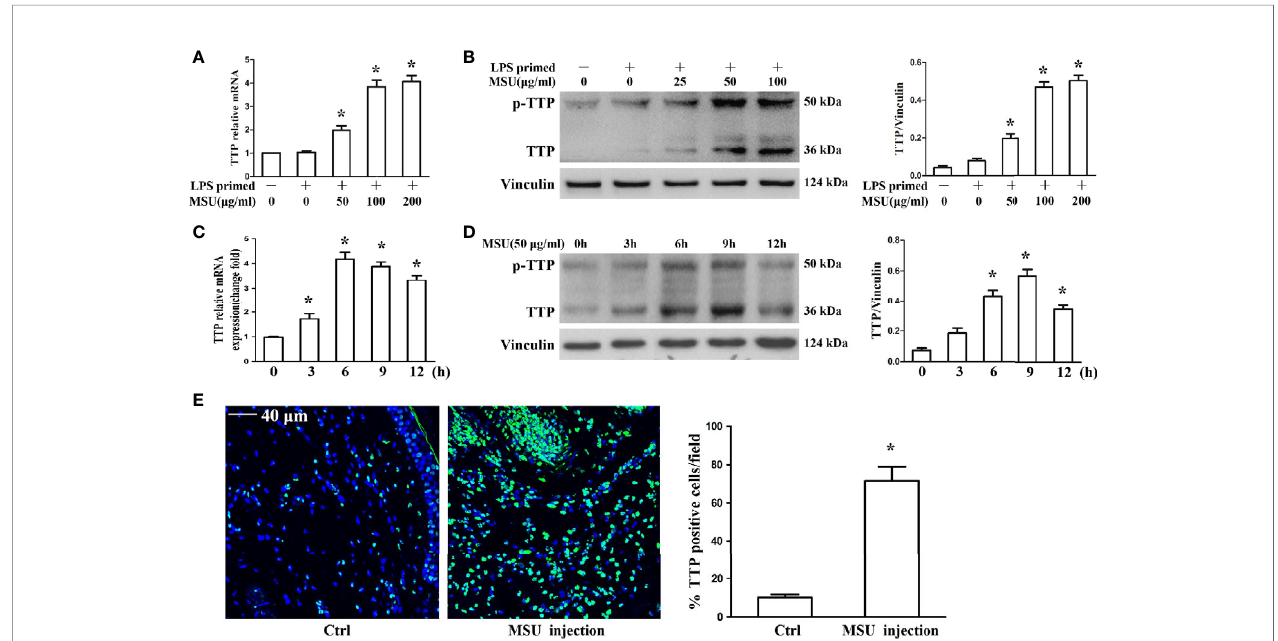
FIGURE 1 | MSU crystals upregulated the expression of TTP in vitro and in vivo . (A, B) J774A.1 cells were primed with 100 ng/ml LPS for 1 h and then treated with different concentrations of MSU crystals for 12 h. (A) Total RNA was extracted from J774A.1 cells and reverse-transcribed, and the mRNA level of TTP was measured by qRT-PCR. *P < 0.05 vs. without MSU crystals treatment. (B) Total protein was isolated from J774A.1 cells, and TTP protein level was detected by Western blot. *P < 0.05 vs. without MSU crystals treatment. (C, D) J774A.1 cells were primed with 100 ng/ml LPS and then treated with 50 m g/ml MSU crystals at various time points (0, 3, 6, 9, 12 h). (C) Total RNA was extracted from J774A.1 cells, reverse-transcribed, and the mRNA level of TTP was measured by qRT-PCR. *P < 0.05 vs. without MSU crystals treatment. (D) Total protein was isolated from J774A.1 cells, TTP protein level was detected by Western blot. *P < 0.05 vs. without MSU crystals treatment. (E) Immuno fl uorescence assay was used to detect TTP protein distribution in mouse foot pad tissue sections. Blue shows nuclei stained with Hoechst 33342. Scale bar: 40 m m. (n=4 per group, mean ± SEM), *P < 0.05 vs. without MSU crystals injection in the foot pad tissue. All the data are expressed as the means ± SEM from n=3 independent